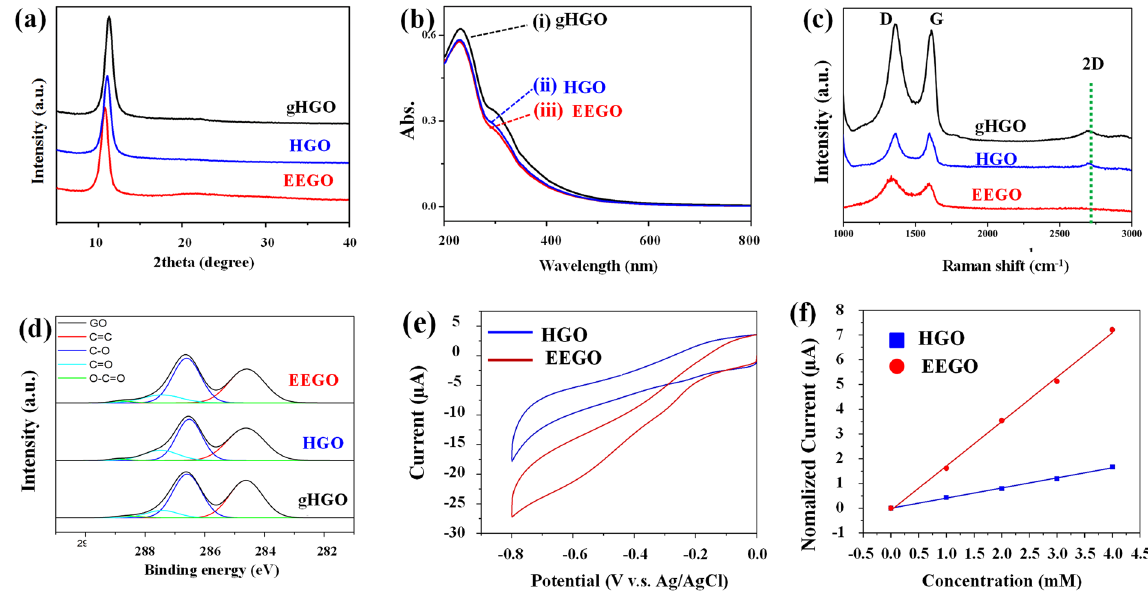
Figure 3. The characterization results and the electrochemical performance comparison of the GO products: ( a ) XRD patterns, ( b ) UV-vis, ( c ) Raman, and ( d ) XPS spectra. ( e ) The reduction current of EEGO and HGO acquired by CV in 5 mM H 2 O 2 . ( f ) The calibration curves of the amperometric responses corresponding to the CVs of EEGO and HGO in Fig. S-4.